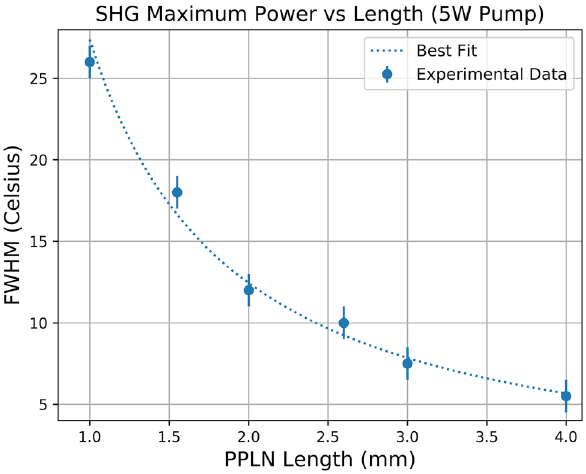
Figure 6. Measured FWHM of temperature curve vs. PPLN length at 5 W 808 nm pump power. The dotted line represents the negative power fit to the data, showing that as the PPLN length increases the FWHM decreases more slowly than at shorter